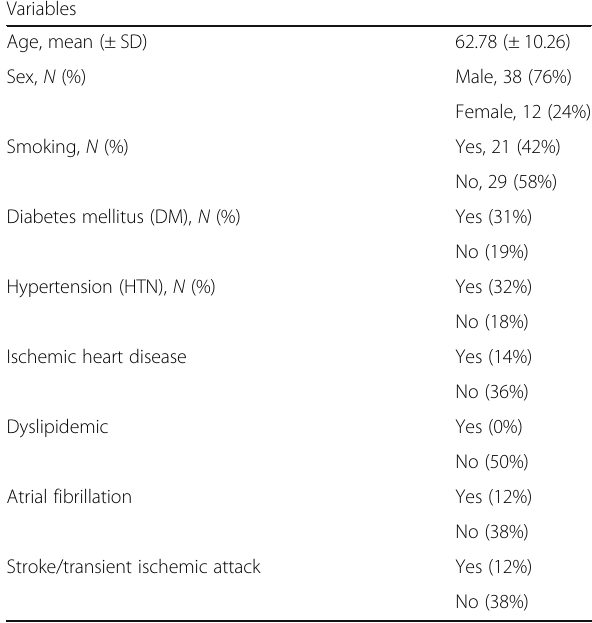
Table 1 Demographic data including risk factors of